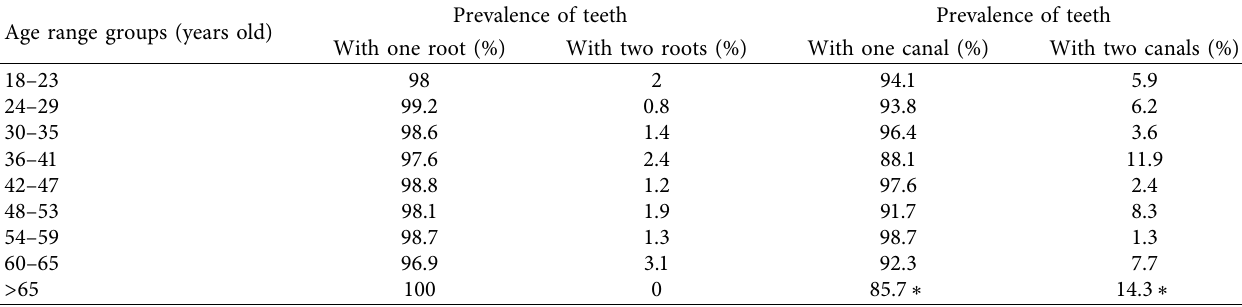
Table 4: Prevalence of root and canal number among different age groups.